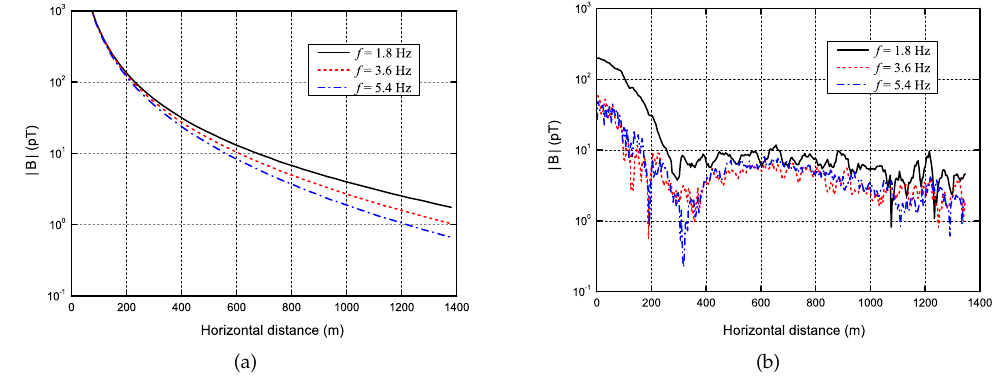
Figure 7. Attenuation of the magnetic strength with ρ at 1.8 Hz, 3.6 Hz and 5.4 Hz. ( a ) Simulation; ( b ) Measurement.